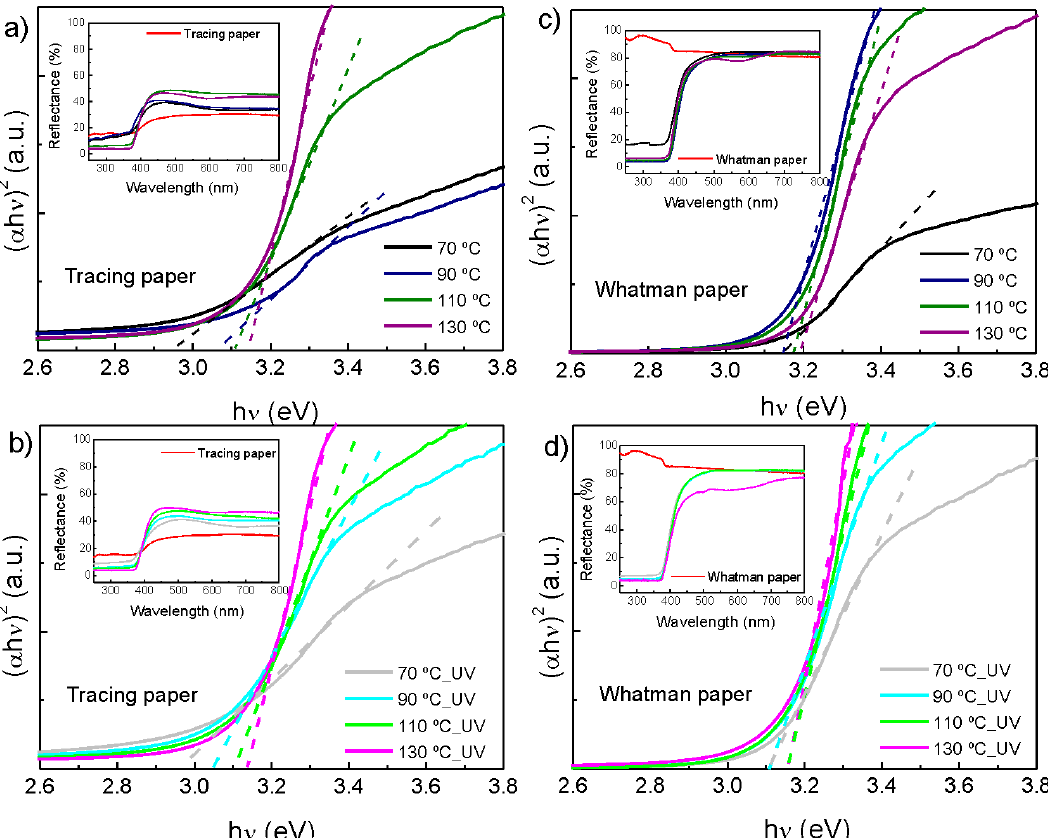
Figure 9. Absorbance spectra of ZnO nanorods arrays produced by an ultrafast hydrothermal method assisted by microwave irradiation, grown on ( a , b ) tracing paper substrate and ( c , d ) Whatman paper substrate, without and with UV/Ozone treatment. All samples were produced with a synthesis time of 10 min.